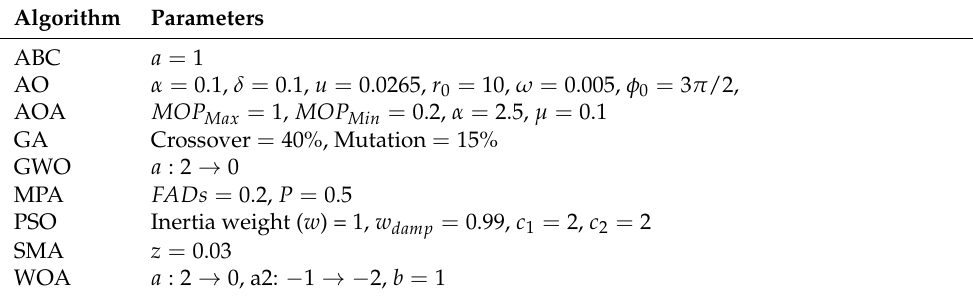
Table 1. Parameter settings of used MH